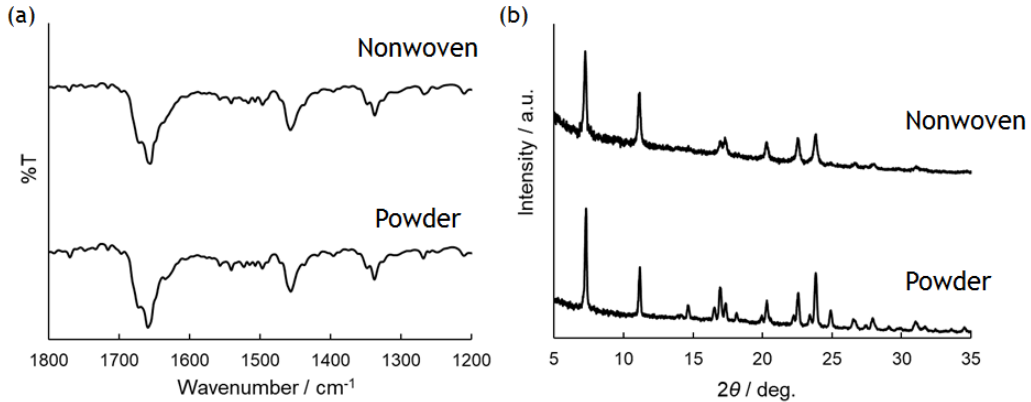
Figure 3. ( a ) FT-IR spectra and ( b ) XRD patterns of as-synthesized and nonwoven PolyPhe prepared by electrospinning of 32 w / v % solution.